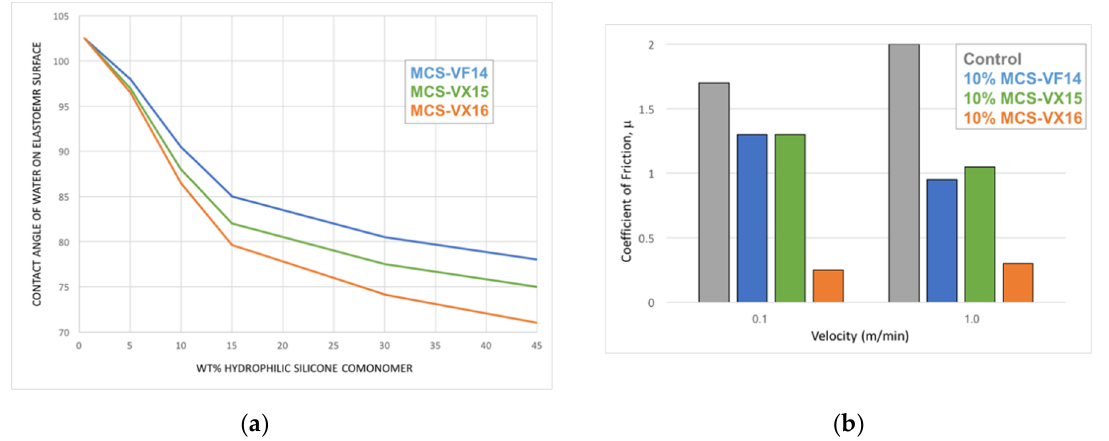
Figure 7. Modification of silicone elastomers with symmetric silicone macromers. ( a ) Effect of comonomer on contact angle and hydrophobicity of silicone elastomer; ( b ) coefficient of friction of silicone elastomers modified with symmetric silicone macromers (Determined on AR-G2 Rheometer: aqueous, 37 °C, normal force 1N, velocity 1.0 rad/s (1.5 mm/s) and 1.0 rad/s (15 mm/s).)